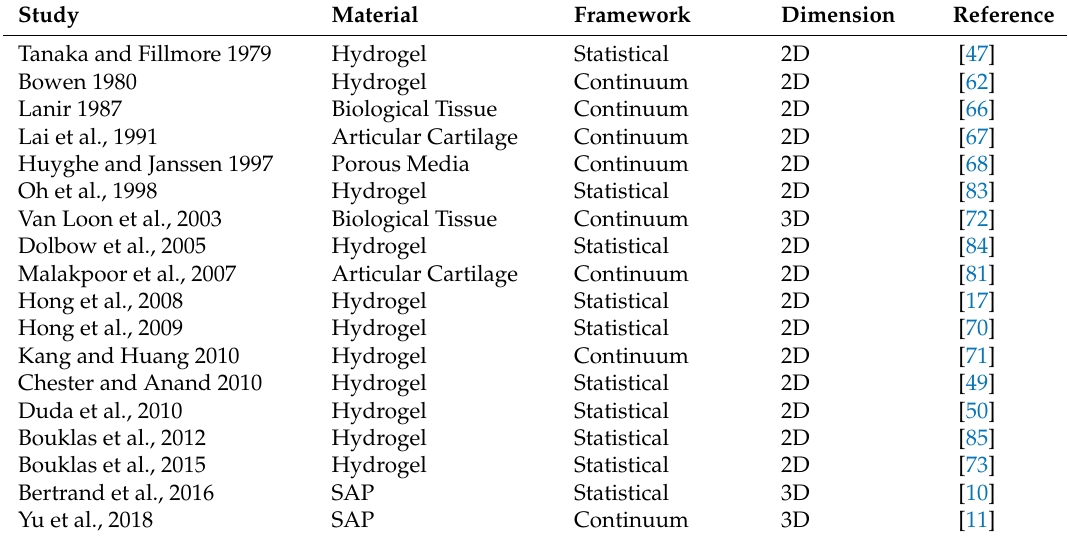
Table 1. Computational models implemented to replicate deformation in porous structures defining the material, strain energy density function theoretical framework, and the dimension reached in each